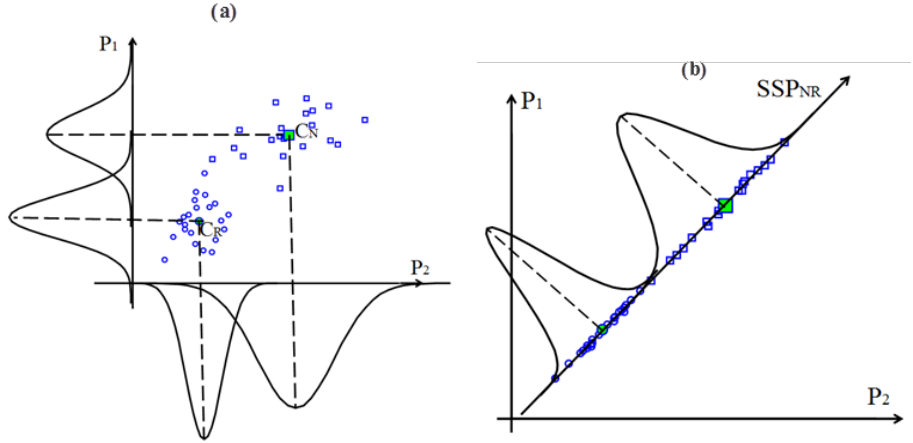
Figure 4. Illustrative example of an SSP: ( a ) probability distributions of P ( b ) probability distributions of SSP